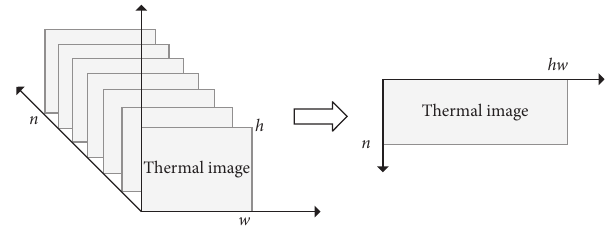
Figure 2: Three-dimensional expansion.